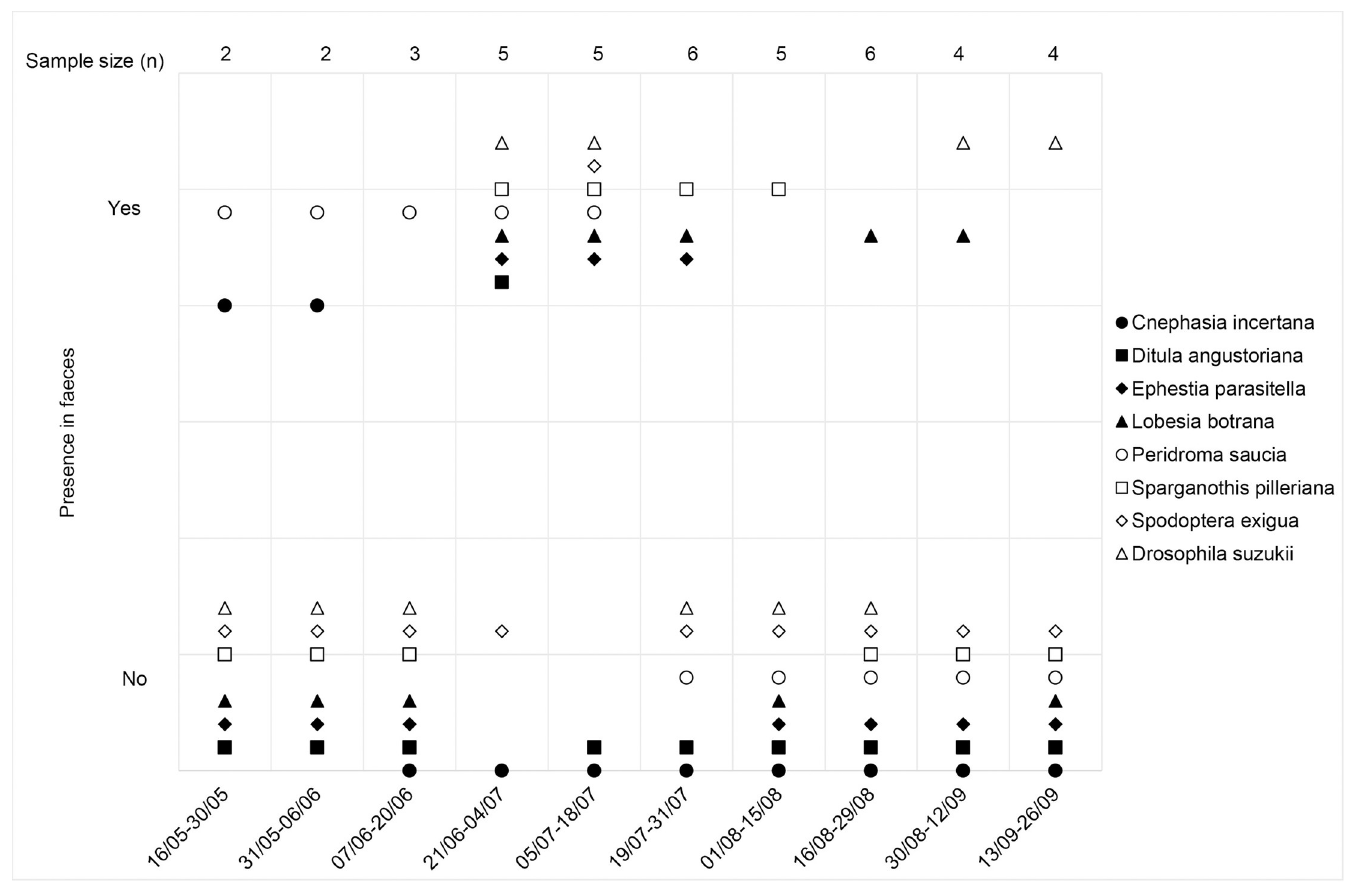
Fig 1. Presence of grapevine pests in faeces of the lesser horseshoe bat R . hipposideros